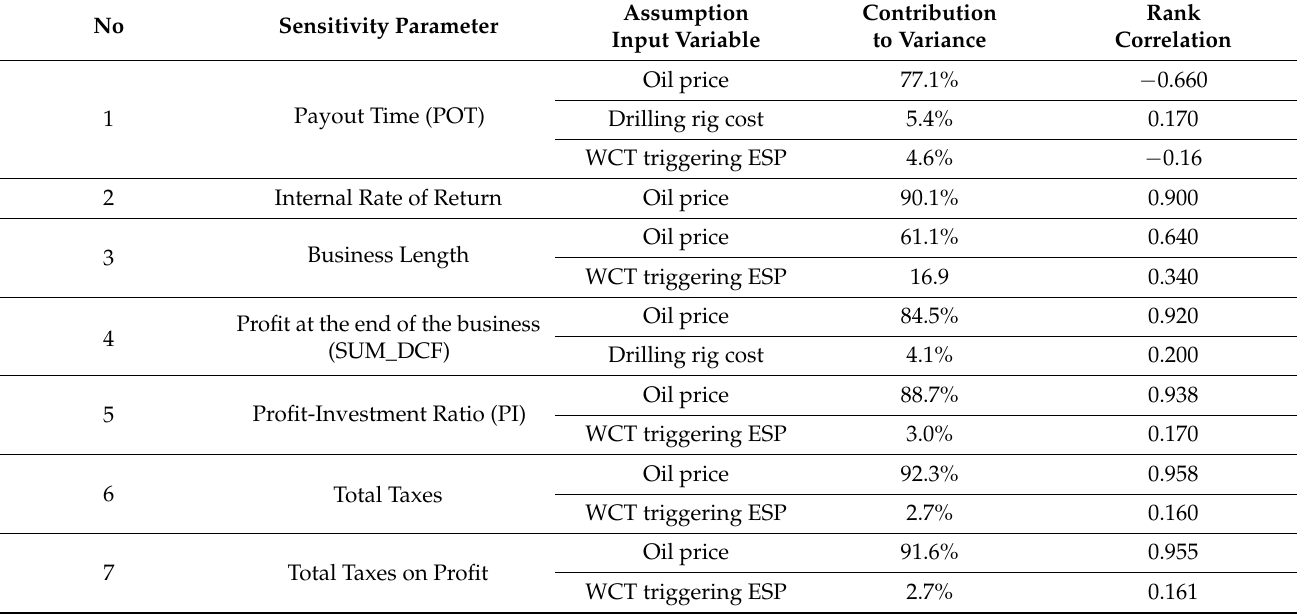
Table 3. Input variables which have the greatest influence on each forecast